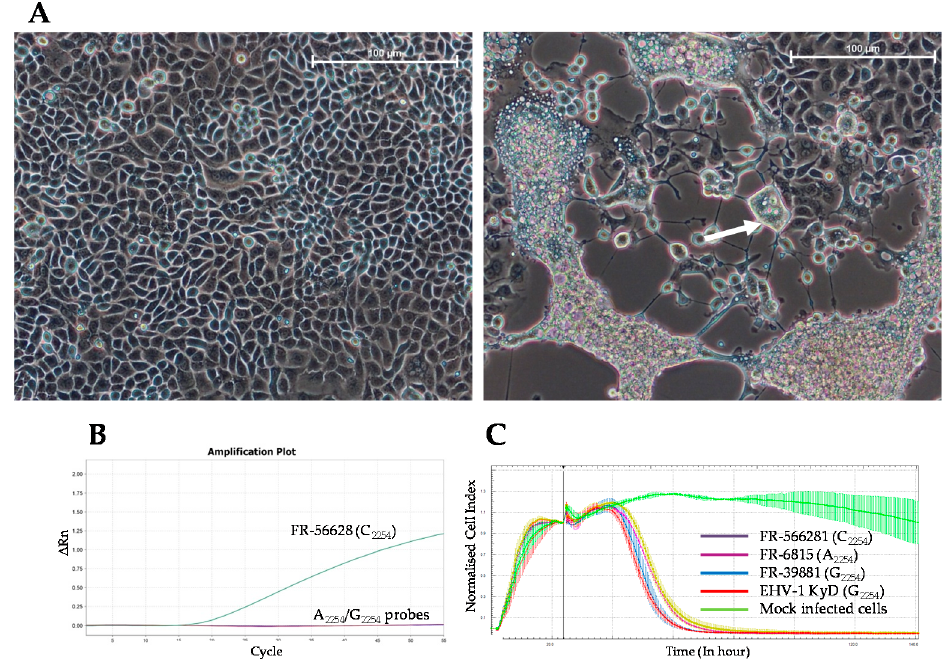
Figure 3. Microscopic observation of RK13 cell monolayer without (left) or with infection with the EHV-1 strain FR-56628 (120 hpi; right). Microscope lens: × 20. Scale bar: 100 µ m. White arrow indicates an example of syncytia formation ( A ). Amplification curves for the EHV-1 strain FR-56628 detected with the C 2254 probe ( B ). Real-time cell analysis of EEK cells infected with EHV-1 strains FR-56628 (C 2254 ; yellow curve), FR-6815 (A 2254 ; purple curve), FR38991 (G 2254 ; blue curve), and reference strain KyD VR700 TM (G 2254 ; red curve) at a multiplicity of infection (MOI) of 0.05, in comparison with mock infected cells (green curve) ( C ).